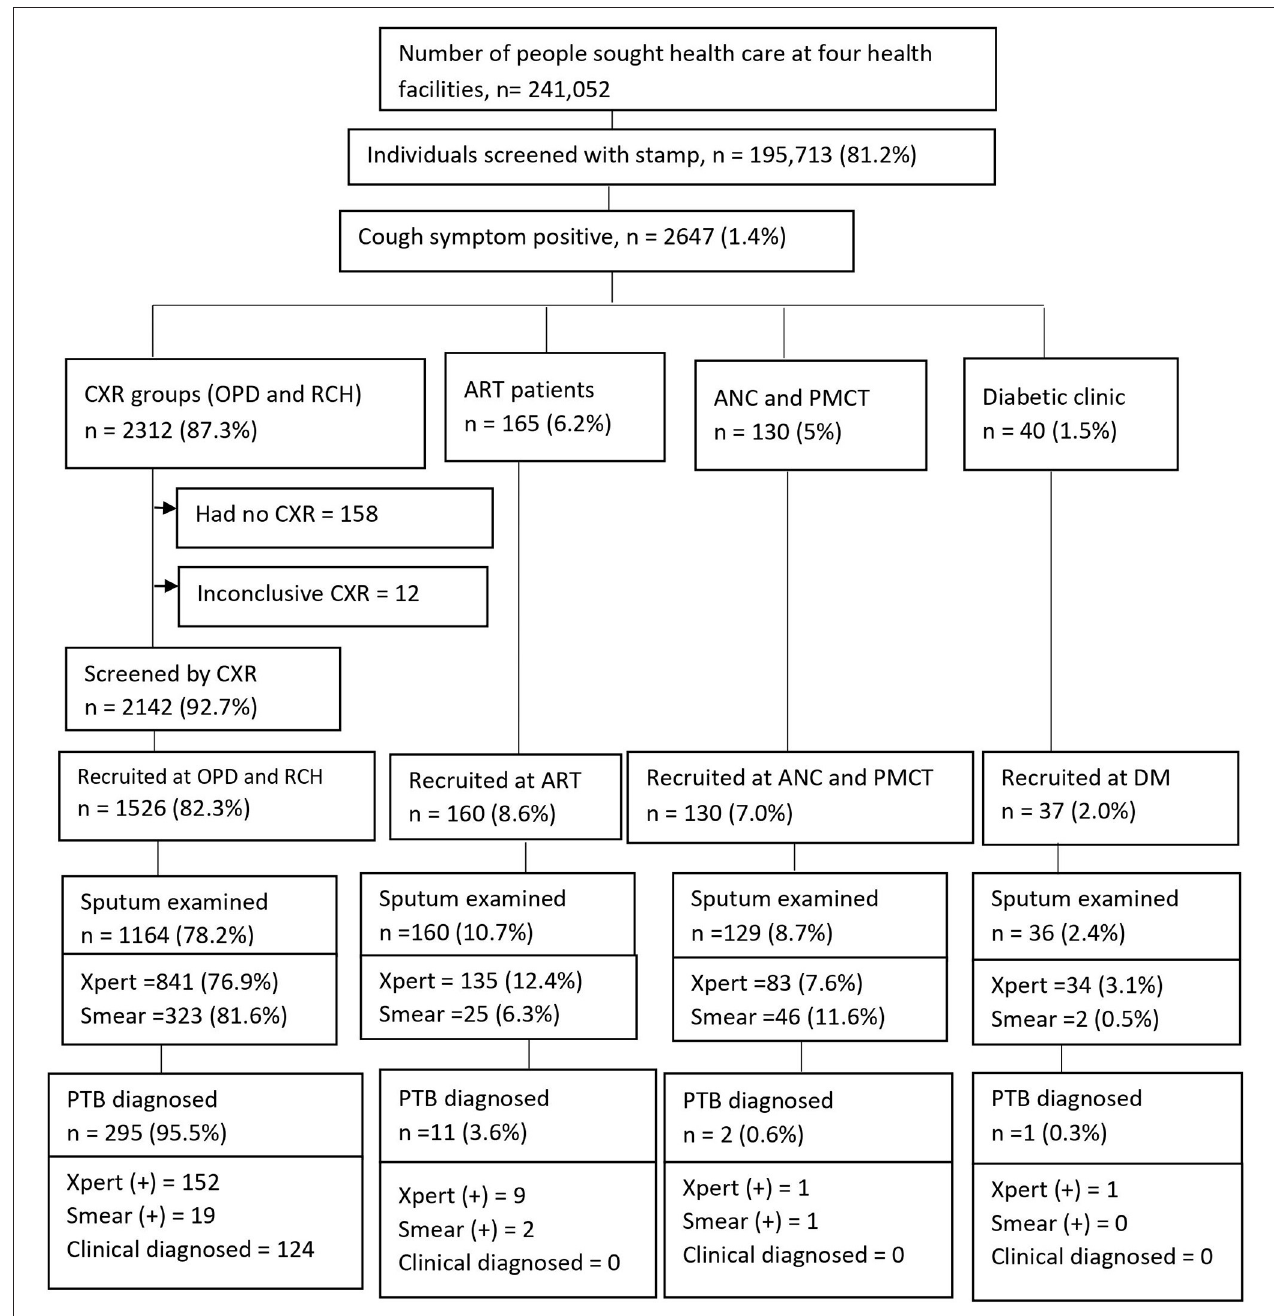
FIGURE 2 | Screening yields for pulmonary tuberculosis cases at health facilities, Ethiopia. CXR, Chest X-ray; OPD, Outpatients department; RCH, Reproductive child health; ANC, Ante-natal care; PMCT, Prevent of mother to child transmission; DM, Diabetic mellitus; ART, Anti-retroviral therapy; PTB, pulmonary